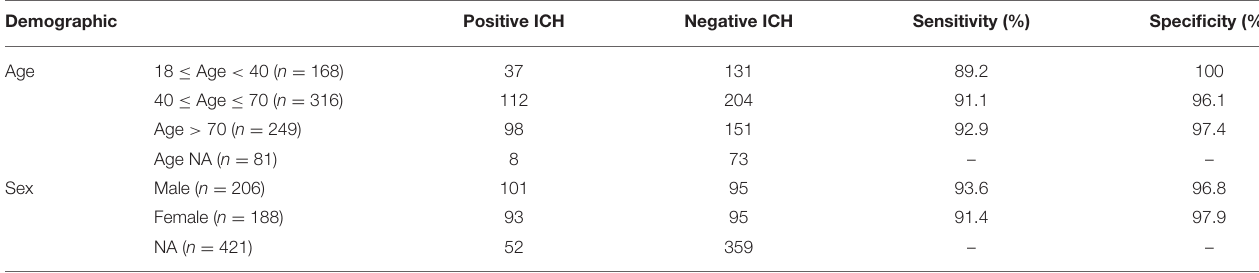
TABLE 2 | Performance metrics for ICH cases based on demographics.